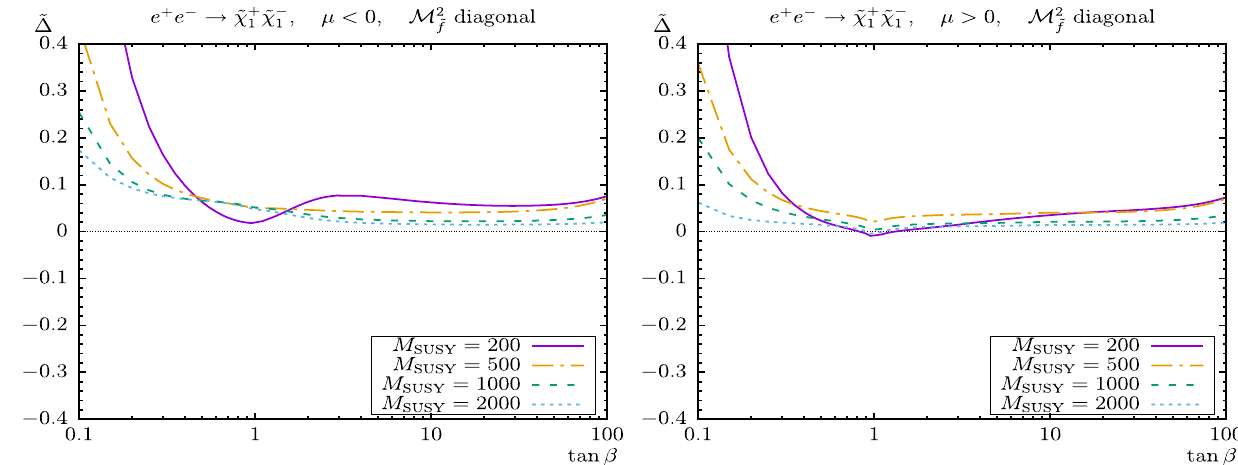
˜ χ − ) . The left (right) plot shows the relative corrections ˜ (cid:7) with t β varied for μ < 0 ( μ > 0) 1 1